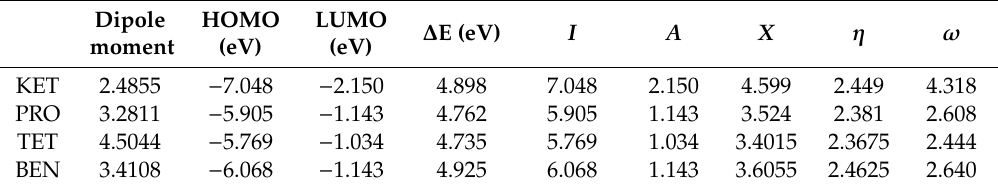
Dipole moments and global reactivity parameters of KET, PRO, TET and